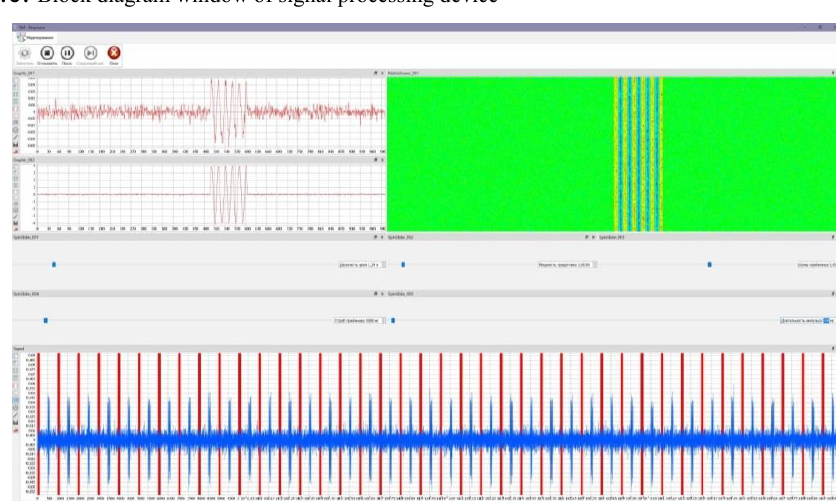
Fig. 6. Simulation results of a signal processing